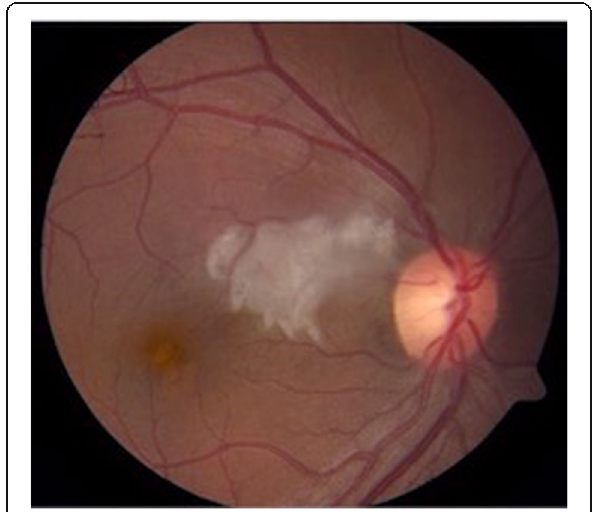
Fig. 3 Color fundus photography of the right eye shows retinal whitening involving the superior papillomacular bundle corresponding to a cilioretinal arterial occlusion in a patient with primary antiphospholipid syndrome